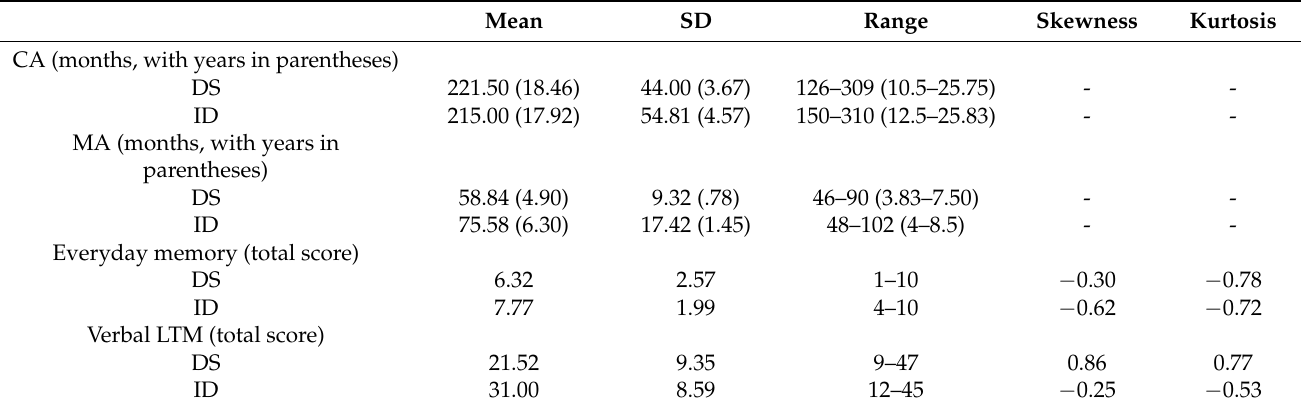
Table 1. Descriptive